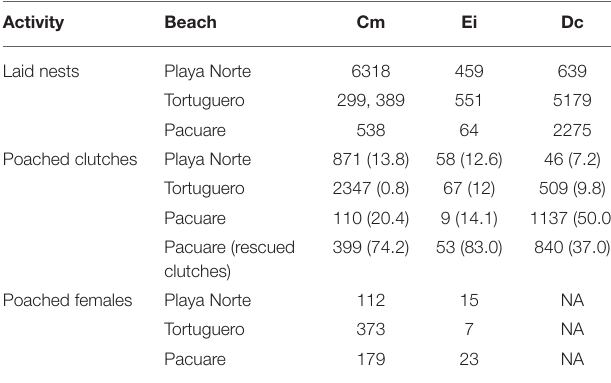
TABLE 1 | Number of nests laid, clutches poached, clutches rescued (Pacuare), and female turtles poached at each site. Activity